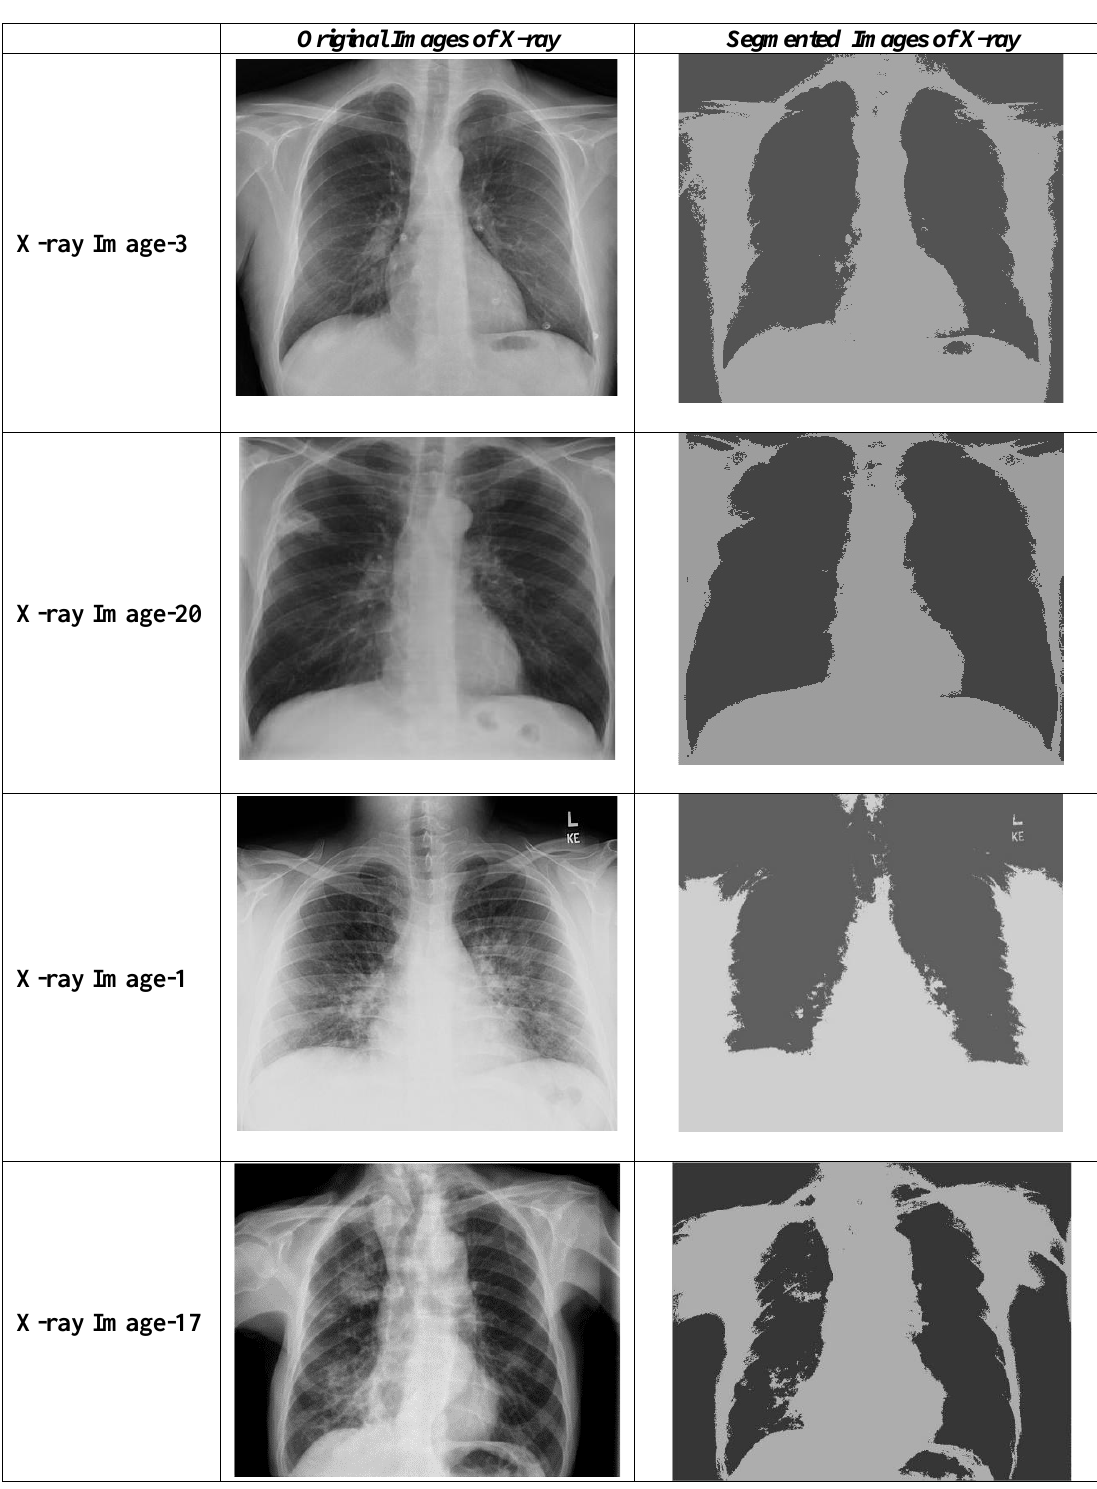
Figure 2. Original and the segmented images of